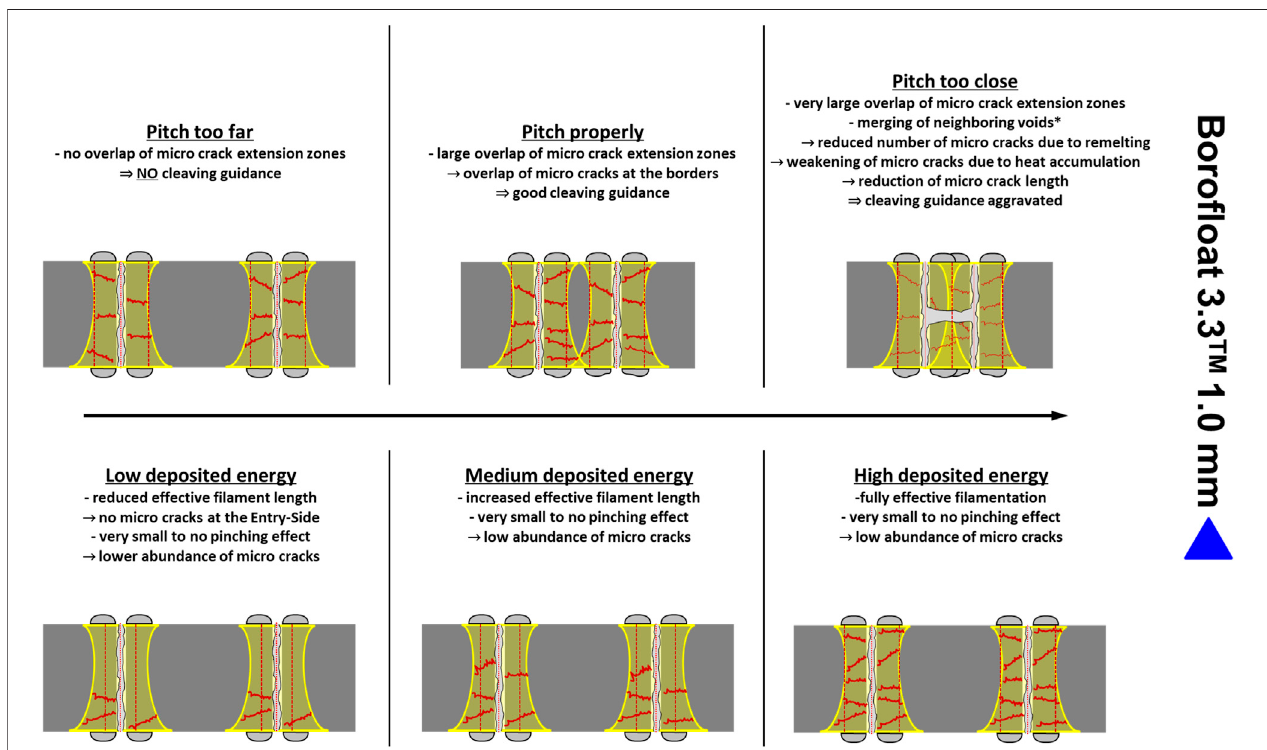
FIGURE 15 | Schematic side view of two fi laments to describe the ongoings of Pitch (top) and Burst (bottom) variation for Boro fl oat 3.3 ™ . The light gray hemispheres on the top and bottom of the surfaces represent the surface modi fi cations (see Figure 3 ). The yellow pro fi les correspond to the maximum crack extension zone affectedbymicrocracks(redcracks) whichisdeducedfromtheroughnesspro fi les(see Figure8 ).Theverticaldashed red linesindicatethelaser-affected zoneas seen in Figure 9 . At the top row, entire effective fi laments with large, open void channels reach through the entire thickness. With a “ Pitch too far ” no interaction between adjacent fi laments is visible and micro cracks are only formed within the maximum micro crack extension zone (yellow). At “ Pitch properly ” the fi laments approach each other, and micro cracks might connect where an overlap of the micro crack extension zones is present. For “ Pitch too close ” a very large overlap of the micro crack extension zones is present and a weakening of the micro cracks is expected as well as large, interconnecting voids are formed due to con fi ned heat accumulation. At the bottom row, no affection of the void morphology was observed. “ Low deposited energy ” caused a reduced effective fi lament length and micro cracks form only at the Focus-Side. “ Medium deposited energy ” increased the effective fi lament length and the micro crack density. With “ High deposited energy ” a thorough effective fi lament is formed. The laser-affected zone (red dashed vertical lines) changes gradually with increasing energy. *merging is expected to be a combination oftooclose fi lamentsgenerated withexceeding deposited energy. Formoredetailedexplanation consider thedescription withinthe fi gureand the detailed explanation in Section 4.9.2 .